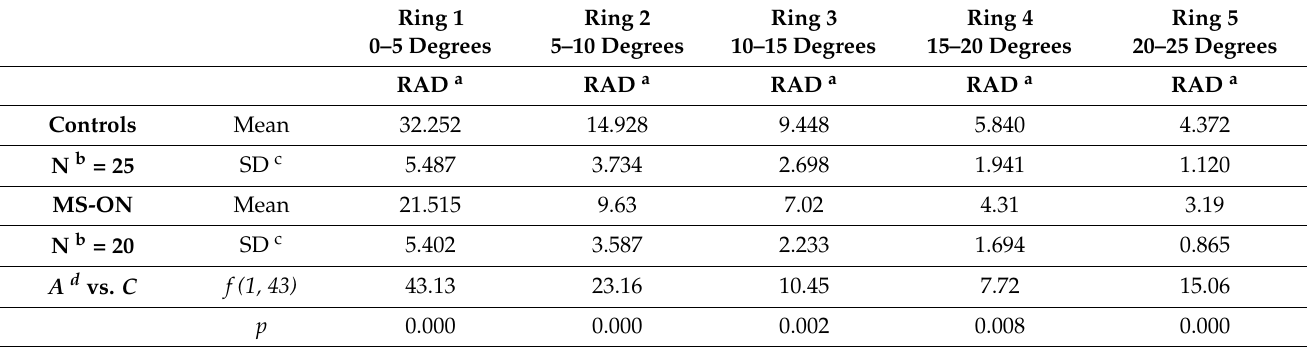
Figure 2. Multifocal photopic negative response (mfPhNR) ring (R) analysis. ( A ) MfPhNR averaged responses from ring 1 to 5 (R1 to R5) are presented from a representative control eye (#7) and from an eye of a multiple sclerosis patient affected by optic neuritis (MS-ON) (#3). The mean mfPhNR response amplitude density (RAD) measure is indicated by an arrow ( (cid:108) ). ( B ) Mean values of mfPhNR RAD (expressed in nanoVolt/degrees 2 , nV/deg 2 ) plotted as a function of foveal eccentricities (R1 to R5 refer to ring analysis (see Methods)). Vertical bars represent one standard deviation of the mean values. Dashed lines indicate the exponential fitting for mfPhNR RADs (Controls: r 2 = 0.97; MS-ON eyes: r 2 = 0.95). The relative functions show a progressive decrease of mfPhNR RADs in both controls and MS-ON eyes with increasing eccentricities (from R1 to R5). The slope of the mean mfPhNR RAD function of both groups presents a greater steepness proceeding from R2 to R3 (the center to periphery transitional retinal areas: from 5 ◦ to 10 ◦ to 10 ◦ to 15 ◦ of foveal eccentricity). * indicates the statistically significant ( p < 0.01) difference between MS-ON and control groups. The values of the statistical analysis are reported in Table 1. Table 1. Mean values of multifocal photopic negative response (mfPhNR) ring analysis observed in Controls (C) compared to multiple sclerosis patients with optic neuritis (MS ‐ ON).